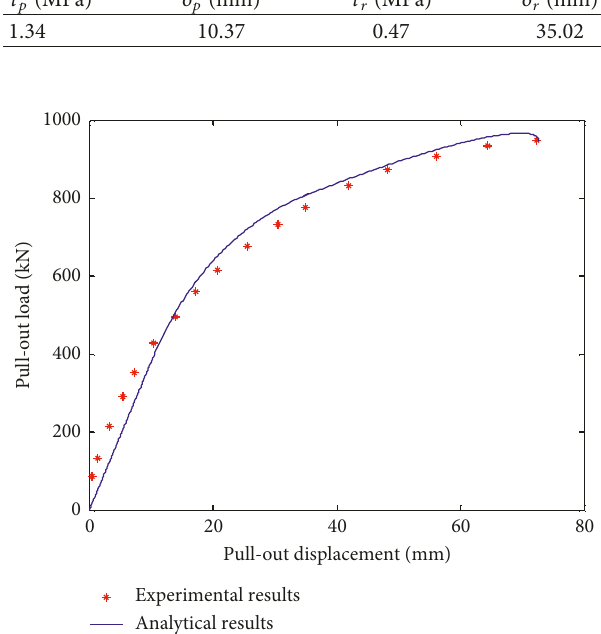
Figure 8: Comparison between the experimental result acquired from Stillborg [59] and the analytical result.